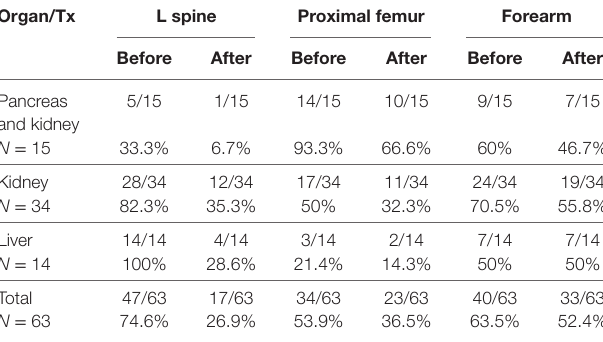
Table 5 | Prevalence of osteoporosis before and after the denosumab therapy. Organ/Tx l spine Proximal femur Forearm before after before after before after Pancreas and